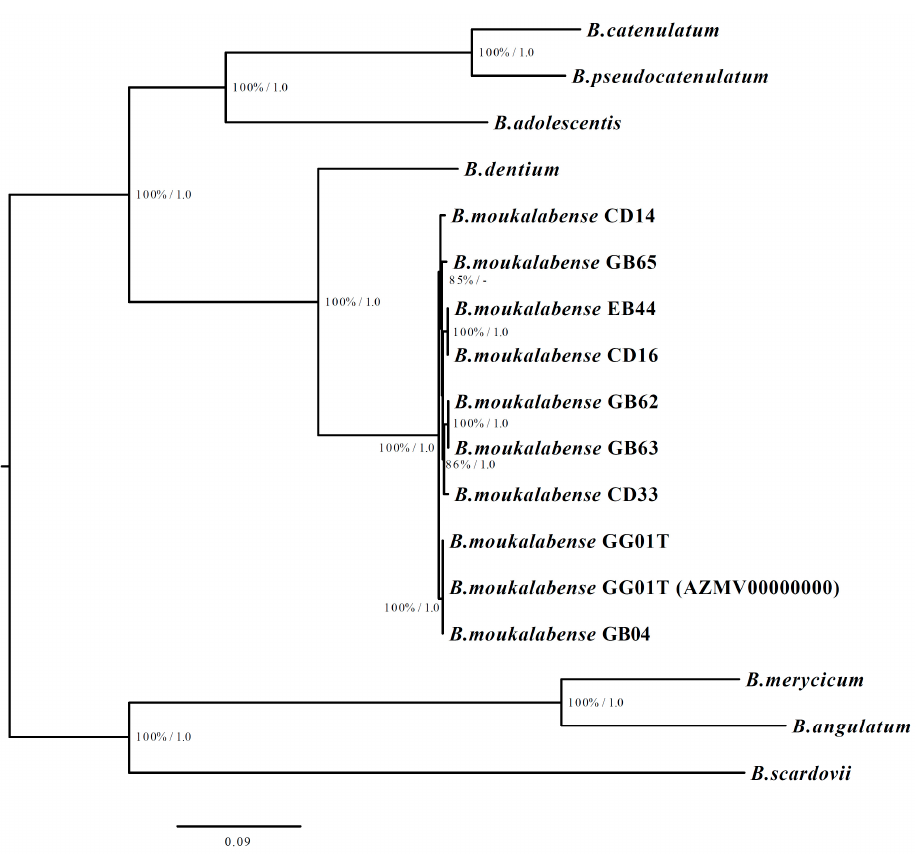
Figure 1. The maximum likelihood tree of B. moukalabense and its related species. The nodal numbers represent the bootstrap values ( left ) and Bayesian posterior probability ( right ). The branch lengths are proportional to the numbers of the nucleotide substitutions.